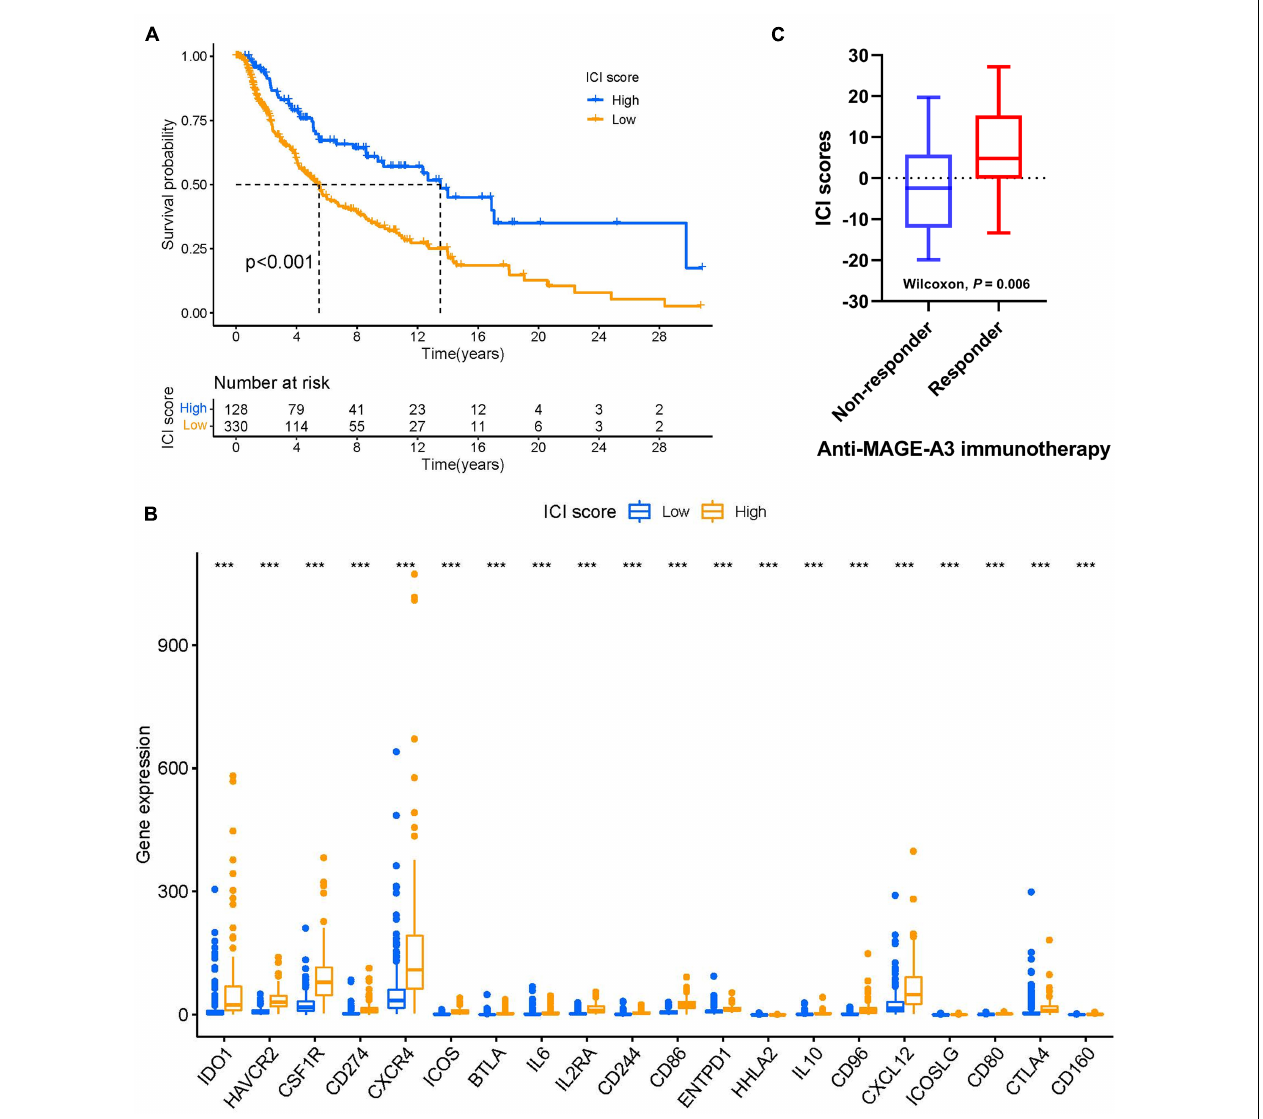
FIGURE 9 | ICI scores predict immunotherapeutic benefit. (A) Kaplan–Meier curves for the high- and low-ICI scores of skin melanoma patients in TCGA-SKCM. Log-rank test shows overall P < 0.001. (B) The expression levels of immune checkpoint-related genes in different ICI score subtypes of SKCM. *** P < 0.001. (C) ICI scores in responders versus non-responders in the anti-MAGE-A3 immunotherapy cohort (Wilcoxon p = 0.06). Medians, interquartile ranges, and minimum/maximum are shown in the boxplot. *** p < 0.001. SKCM, skin cutaneous melanoma; ICI, immune cell